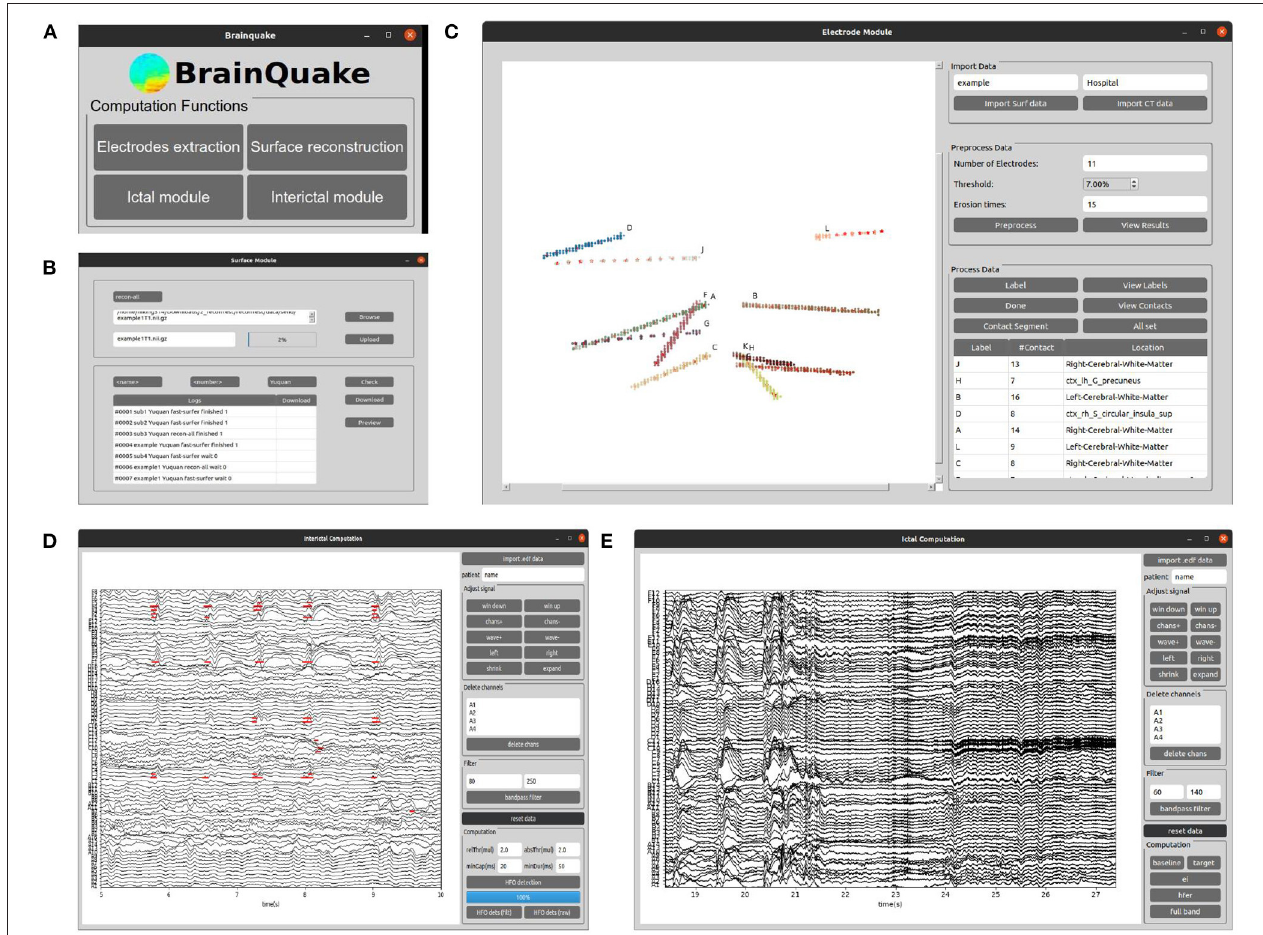
FIGURE 2 | The graphical user interfaces (GUIs) of the main window of BrainQuake and the four functional submodules. (A) BrainQuake main window; (B) Surface module; (C) Electrode module; (D) Interictal module; (E) Ictal